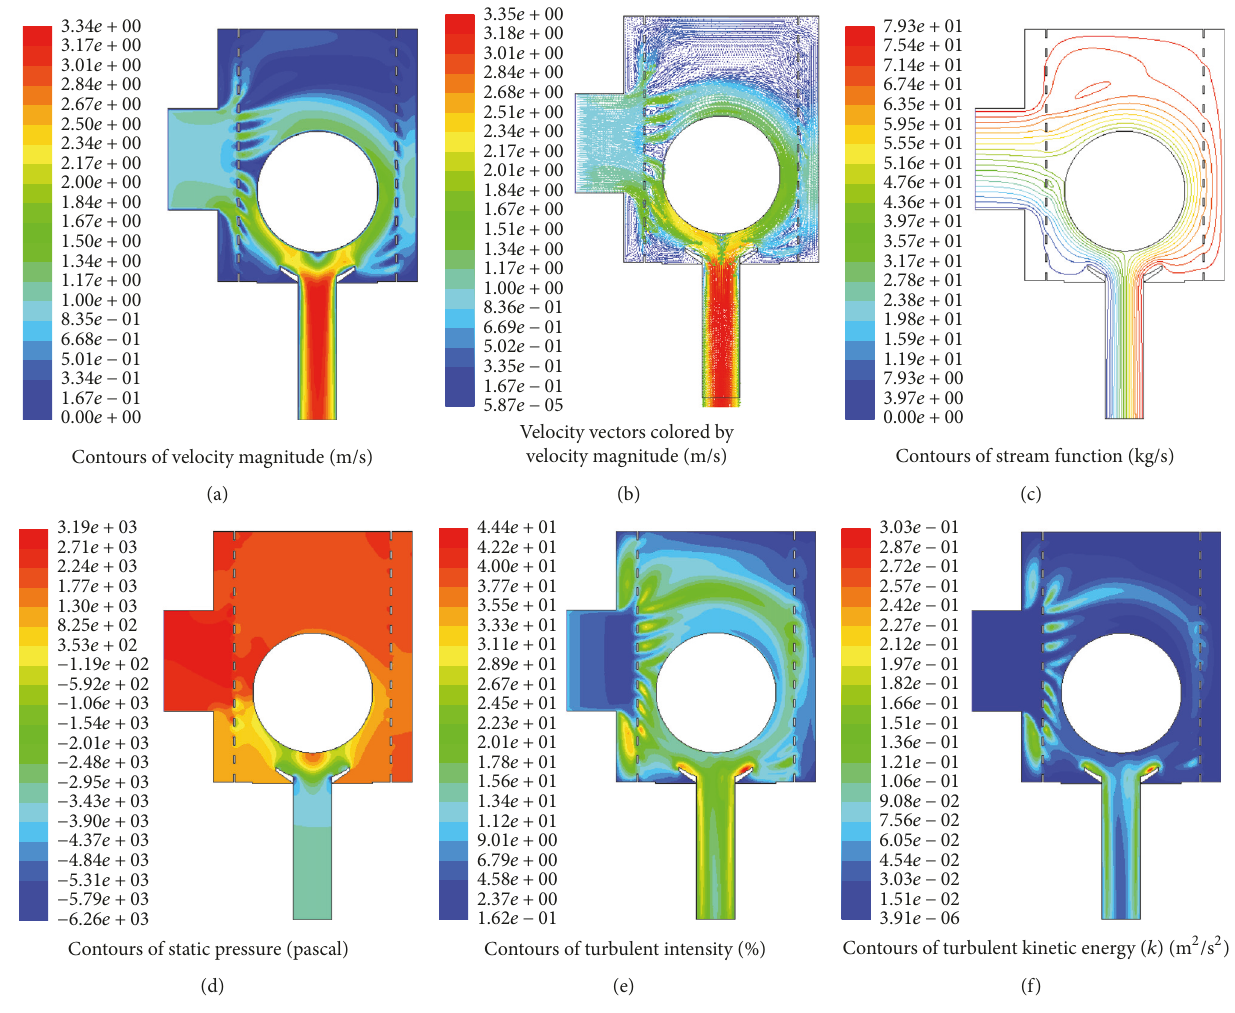
Figure 7: (a) Contours of velocity magnitude; (b) contours of velocity vector; (c) contours of stream function; (d) contours of static pressure; (e) contours of turbulent intensity; (f) contours of turbulent kinetic energy after installation of grids at T3 moment.